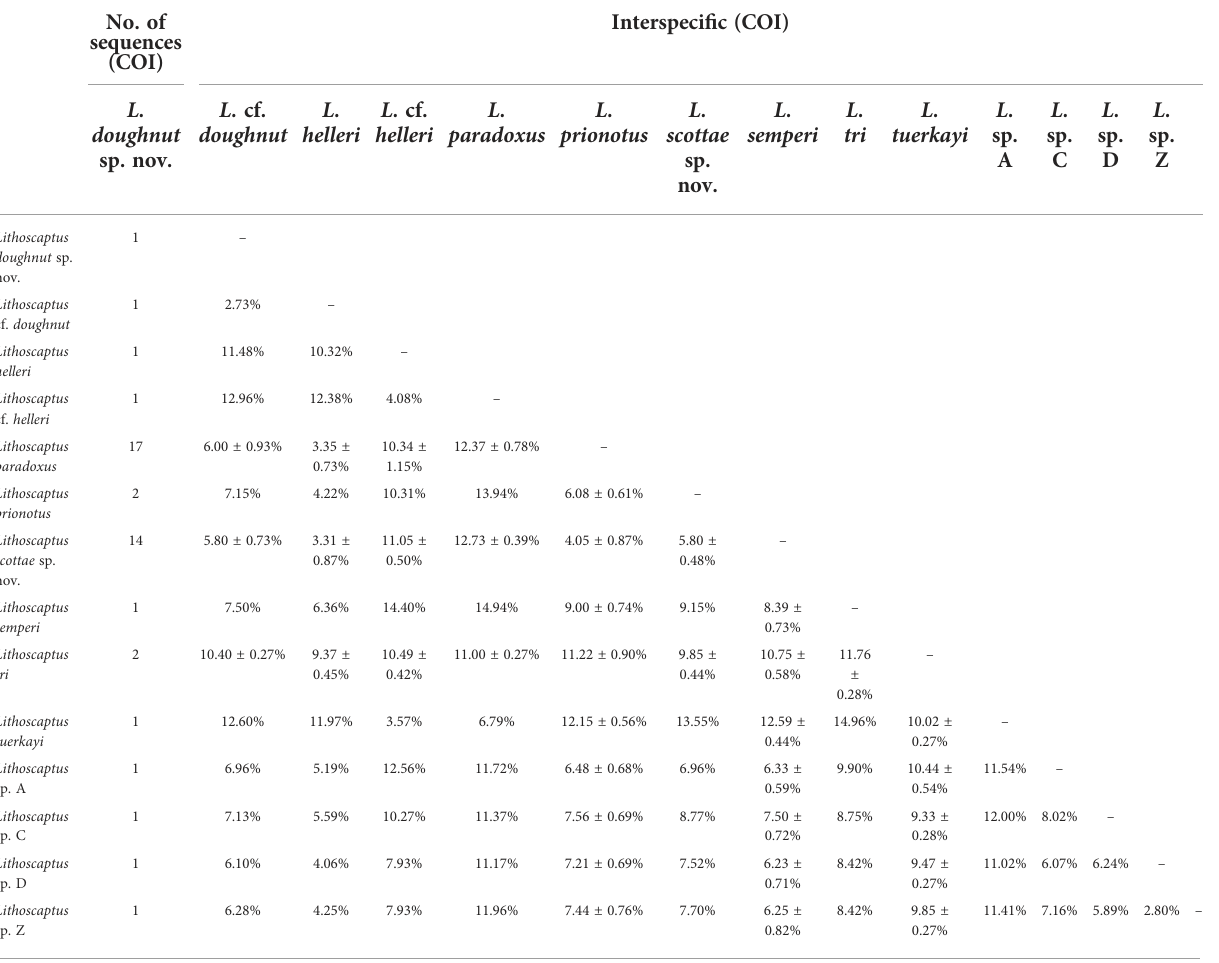
like structure (Figure 11H). Plp1 to Plp3 uniramous (Figures 11O – Q).